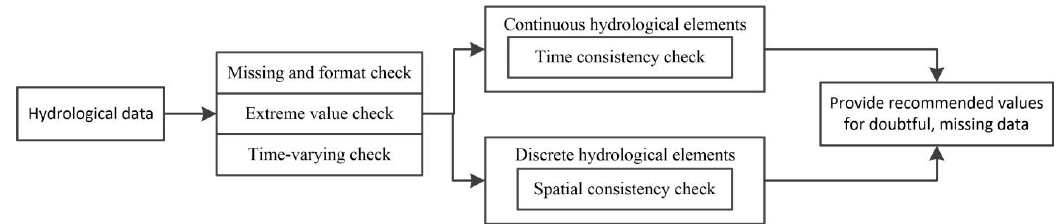
Figure 1. Quality control framework for hydrological data.